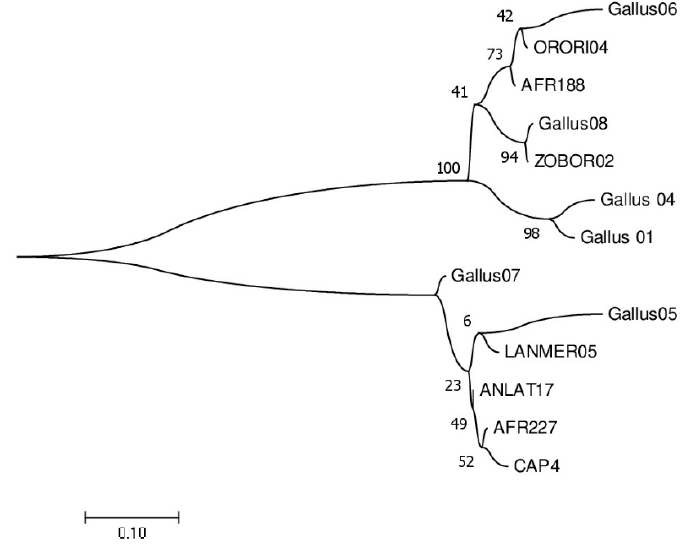
Figure 1. Phylogenetic relationships among the 13 haemosporidian lineages identified in this study. The number of branches represents bootstrap values derived from 1000 replicates.